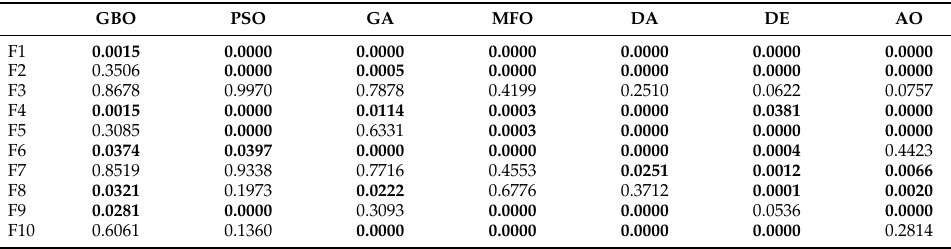
Table 6. Results of the Wilcoxon rank-sum test for global optimization.